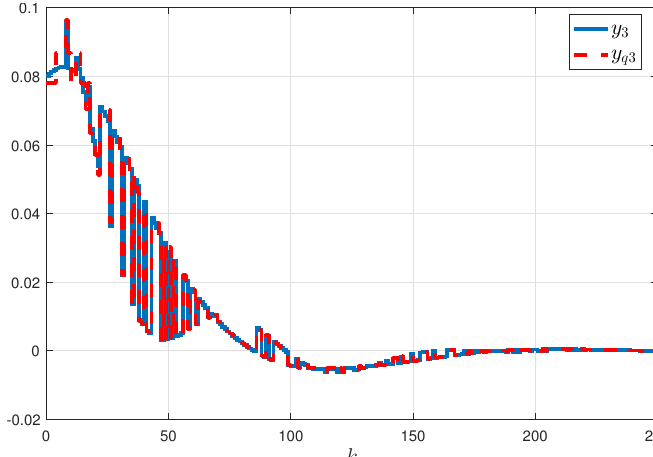
Figure 4. Actual output, y 3 , and quantized output, y q 3 .